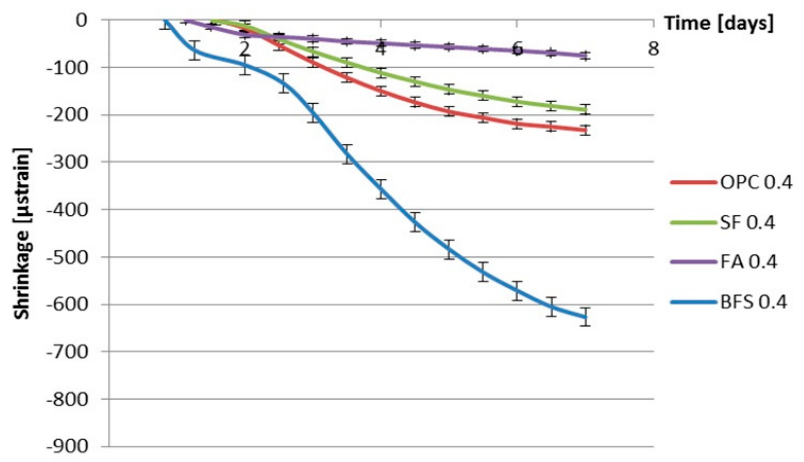
Figure 15. Autogenous deformation vs. age for different kinds of cement paste with water–binder ratio of 0.4 (starting time: after early-age swelling).